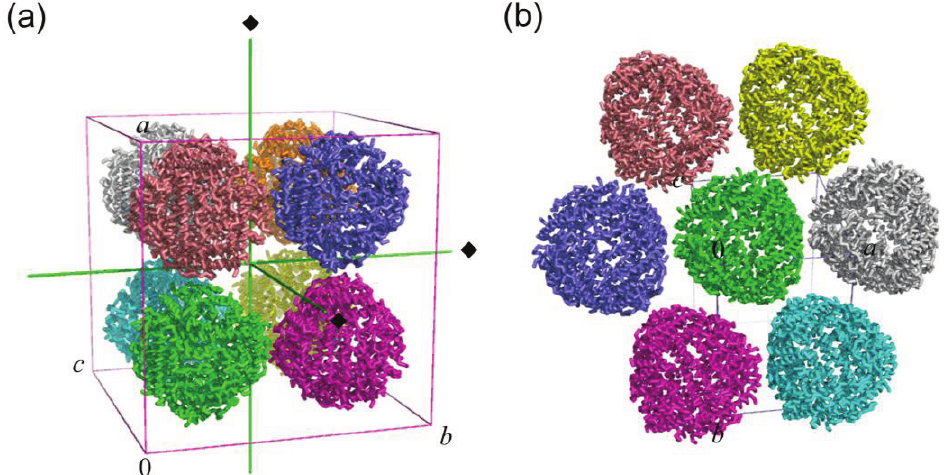
Figure 2. Crystal packing of Fe-loaded HP-NAPs from strains YS39 (PDB ID: 3TA8) ( a ) and 26695 (PDB ID: 1JI4) ( b ). Each dodecamer is shown in a different color. Green lines indicate four-fold axes. Each unit cell is also